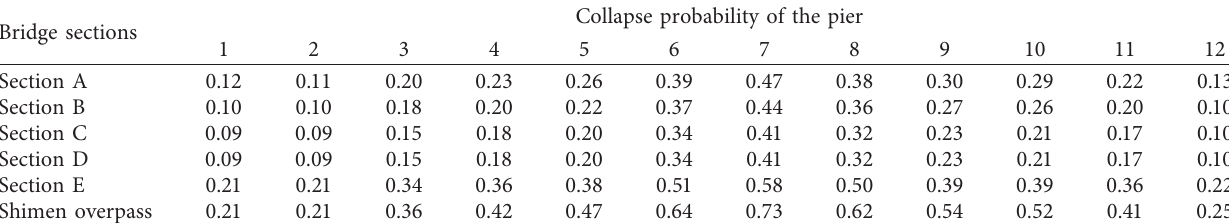
Table 7: Calculated collapse probability of the pier of bridge sections.